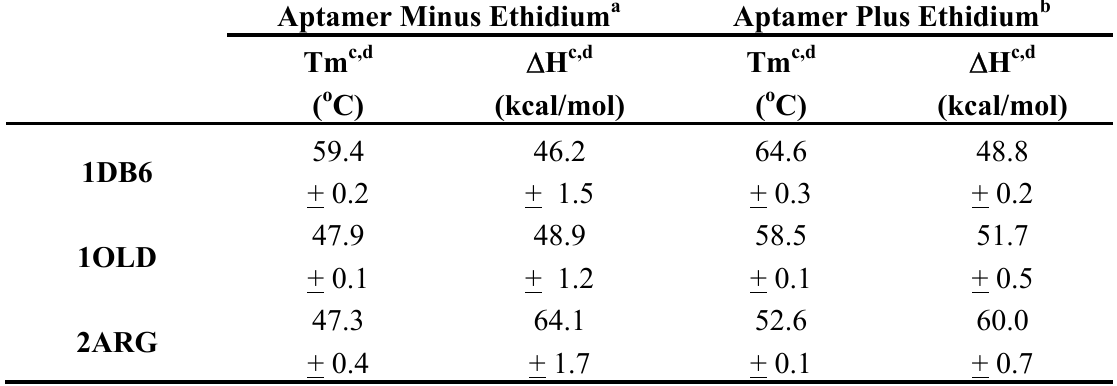
Table 2. Effect of ethidium binding on the fitted thermal denaturation parameters for L- argininamide binding DNA